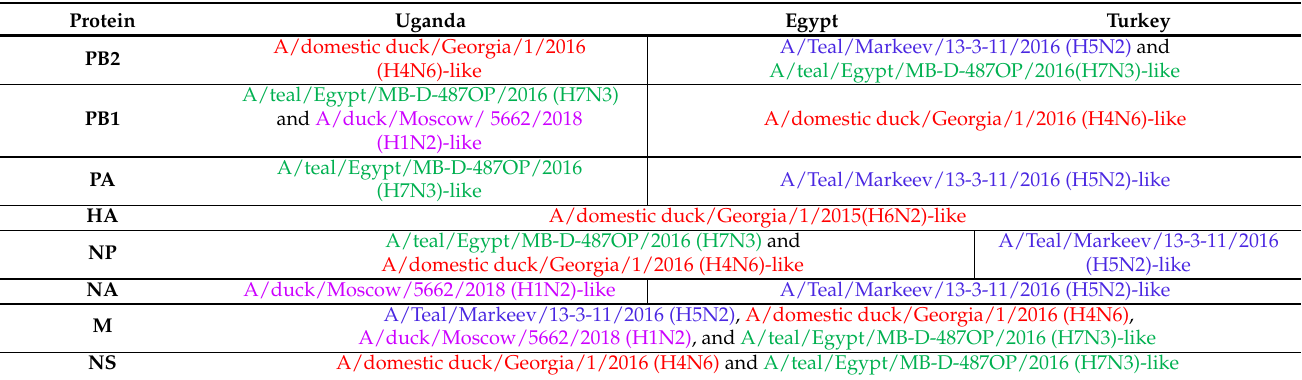
Table 2. Genetic constellations of Ugandan, Egyptian, and Turkish